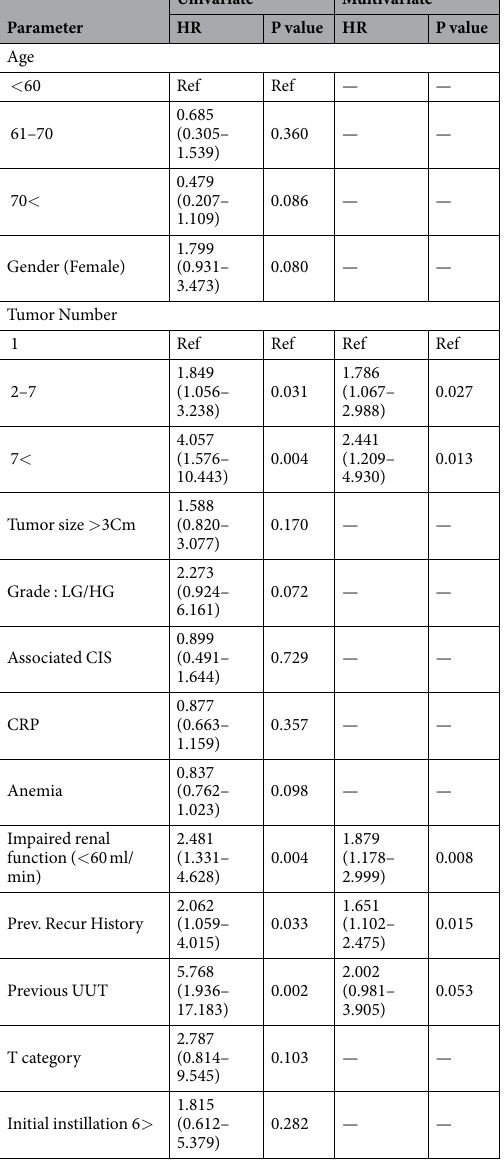
Table 3. Univariate and multivariate analyses of predictors for recurrence after intravesical BCG